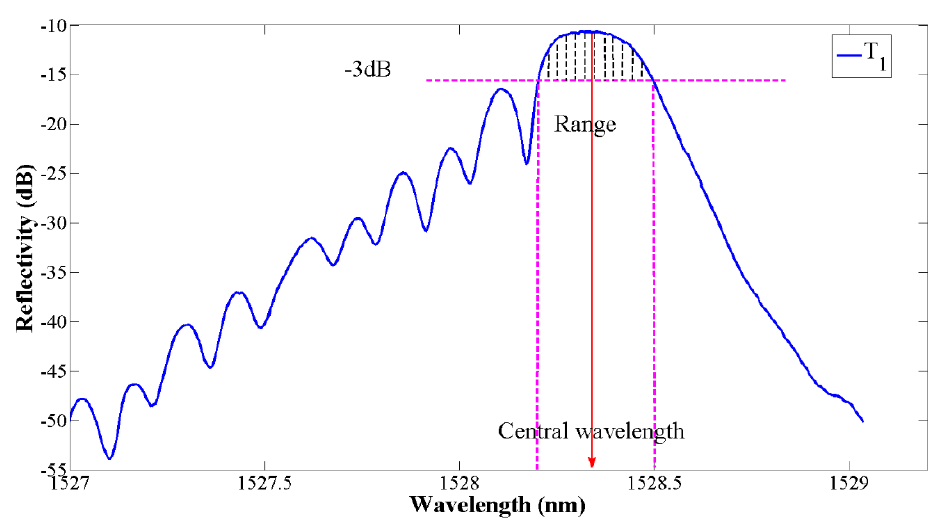
Figure 6. Schematic of the central wavelength detection by centroid algorithm.